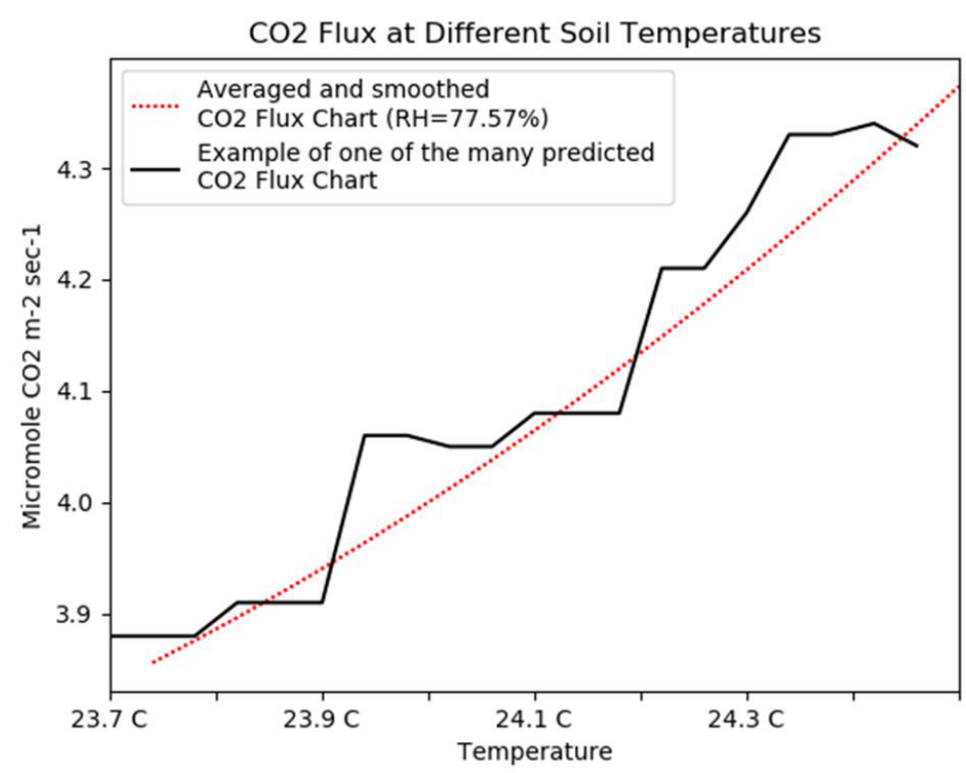
Figure 8. Results of experiment 7. Dependence of CO 2 flux rate on relative humidity. As in experiment 6, the main point is the “ Averaged and Smoothed CO 2 Flux ” chart.